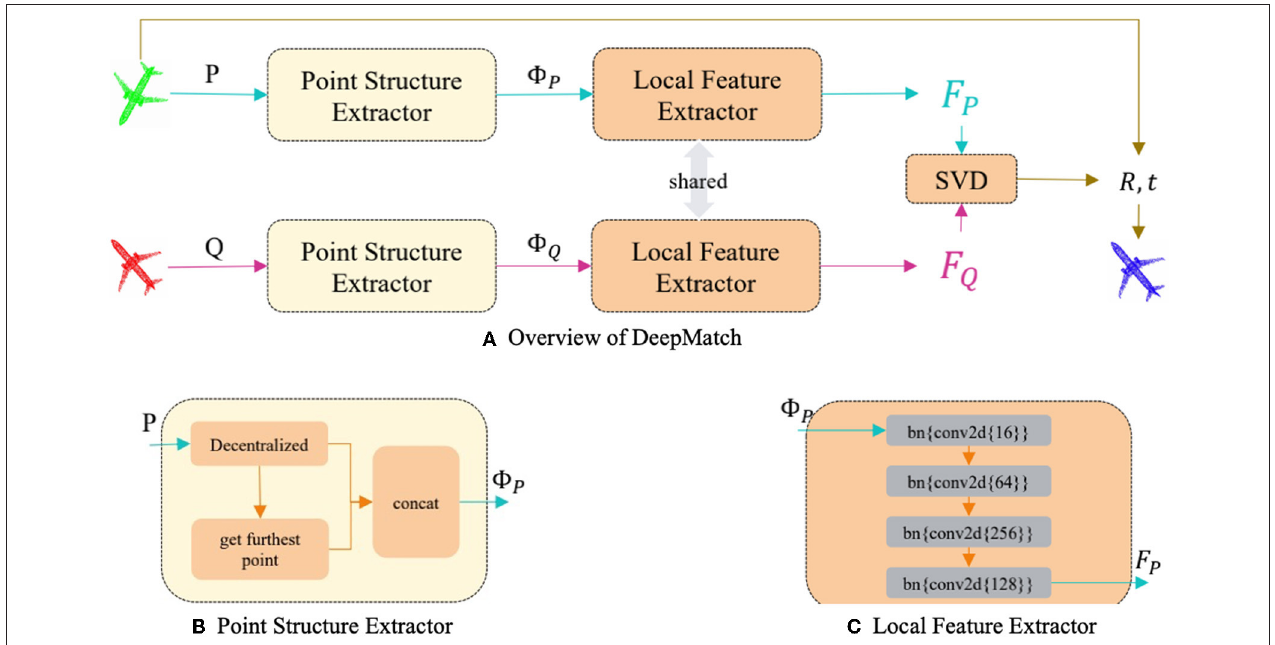
FIGURE 2 | The pipeline of our DeepMatch (A) simply consists of Point Structure Extractor, Local Feature Extractor, and a differentiable SVD part, (B,C) respectively, show the details of Point Structure Extractor and Local Feature Extractor.